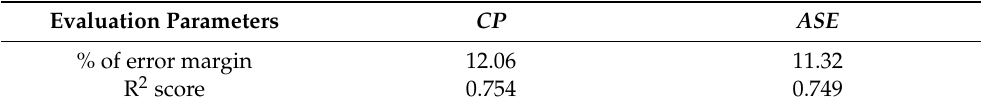
Table 6. Evaluation of the finalized